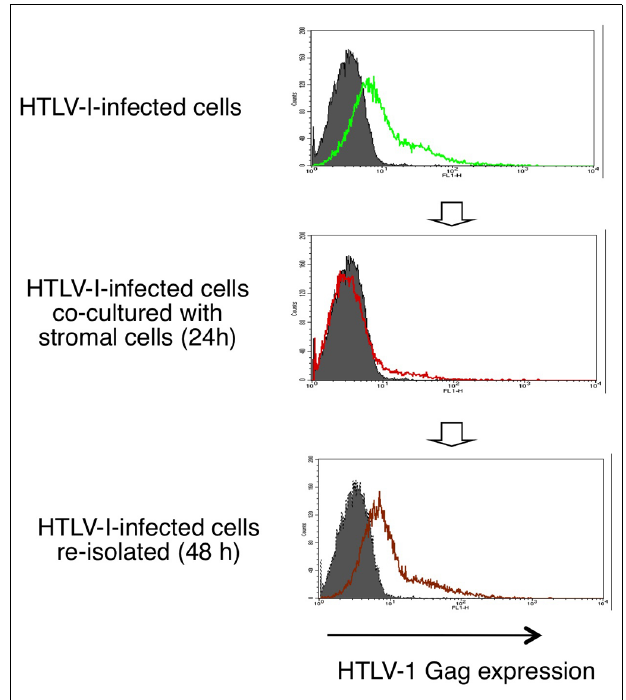
FIGURE 3 | Reversible suppression of HTLV-1 expression by stromal cells through type-I IFNs. HTLV-1 protein expression in HTLV-1-infected T-cells are markedly decreased when co-cultured with stromal cells and recovers after re-isolation from the co-cultures (Kinpara etal.,